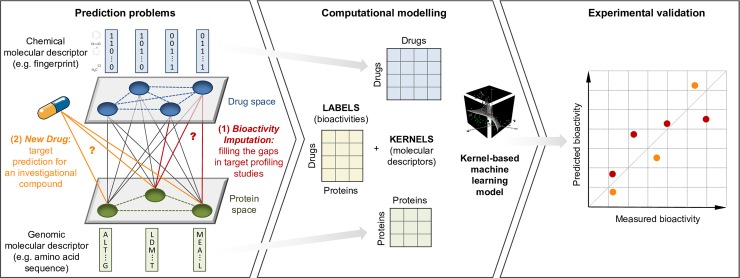
An overview of our computational-experimental framework for prediction and pre-clinical testing of compound-protein bioactivity profiles.Two separate prediction problems are considered: (1) filling the gaps in existing compound-target interaction maps and (2) prediction of target interactions for a new or investigational compound. Molecular descriptors of drug compounds and protein targets are encoded as kernels, and used for binding affinity prediction with a regularized least squares regression model KronRLS. Finally, a subset of predicted compound-protein bioactivities is experimentally tested (see Materials and Methods for details). Since the experimental validations do not exists at the time of making the predictions, this approach effectively assesses any potential model overfitting to the training data only. We chose to use kernel-based models as these are well-suited for representing structured objects, such as molecules, that cannot be accurately described by a standard feature vector. Different types of drug and protein kernels can be calculated using readily available chemical structures and amino acid sequences. The resulting matrices associate all pairs of input objects, and therefore a kernel function can be considered as a similarity measure.